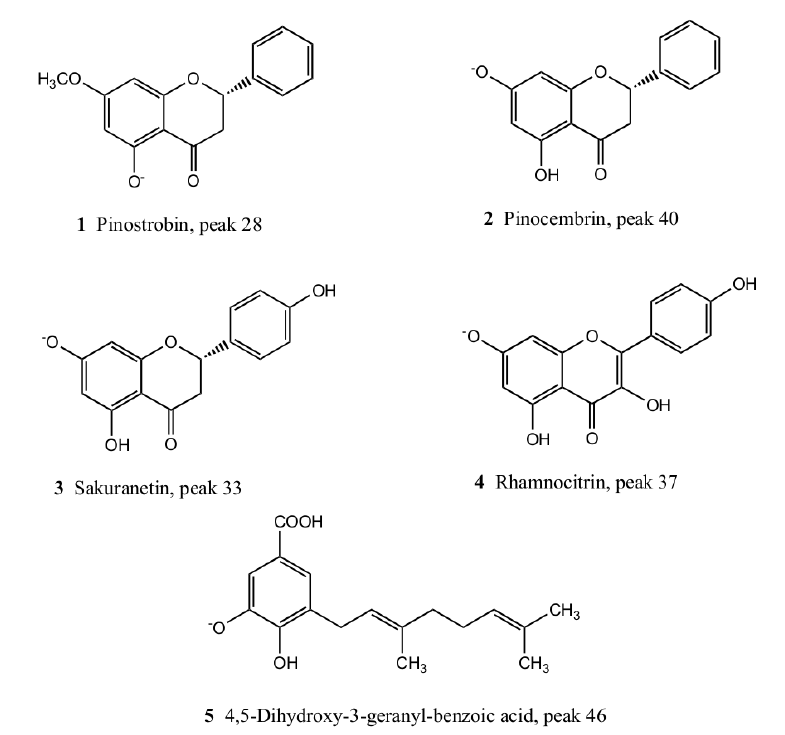
Figure 5. Isolated compounds from H. taltalense methanolic extract. 5-hydroxy-7-methoxy-flavanone (pinostrobin; 1 ), 5,7′-dihydroxy-flavanone (pinocembrin; 2 ), 4′,5 -dihydroxy-7-methoxy-flavanone (sakuranetin ; 3 ), 3,5,4′trihydroxy-7-methoxy-flavone, (rhamnocitrin; 4 ), and 4,5 dihydroxy-3-geranyl-benzoic acid ( 5 ).